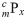
The measurement reference of GCPC.The (a
x, b
x, d
x) and (e
x, g
x) corresponds to the Pmcx while the (a
y, b
y, d
y) and (e
y, g
y) corresponds to the Pmcy. The two dotted circles are determined by the two solid arcs respectively.